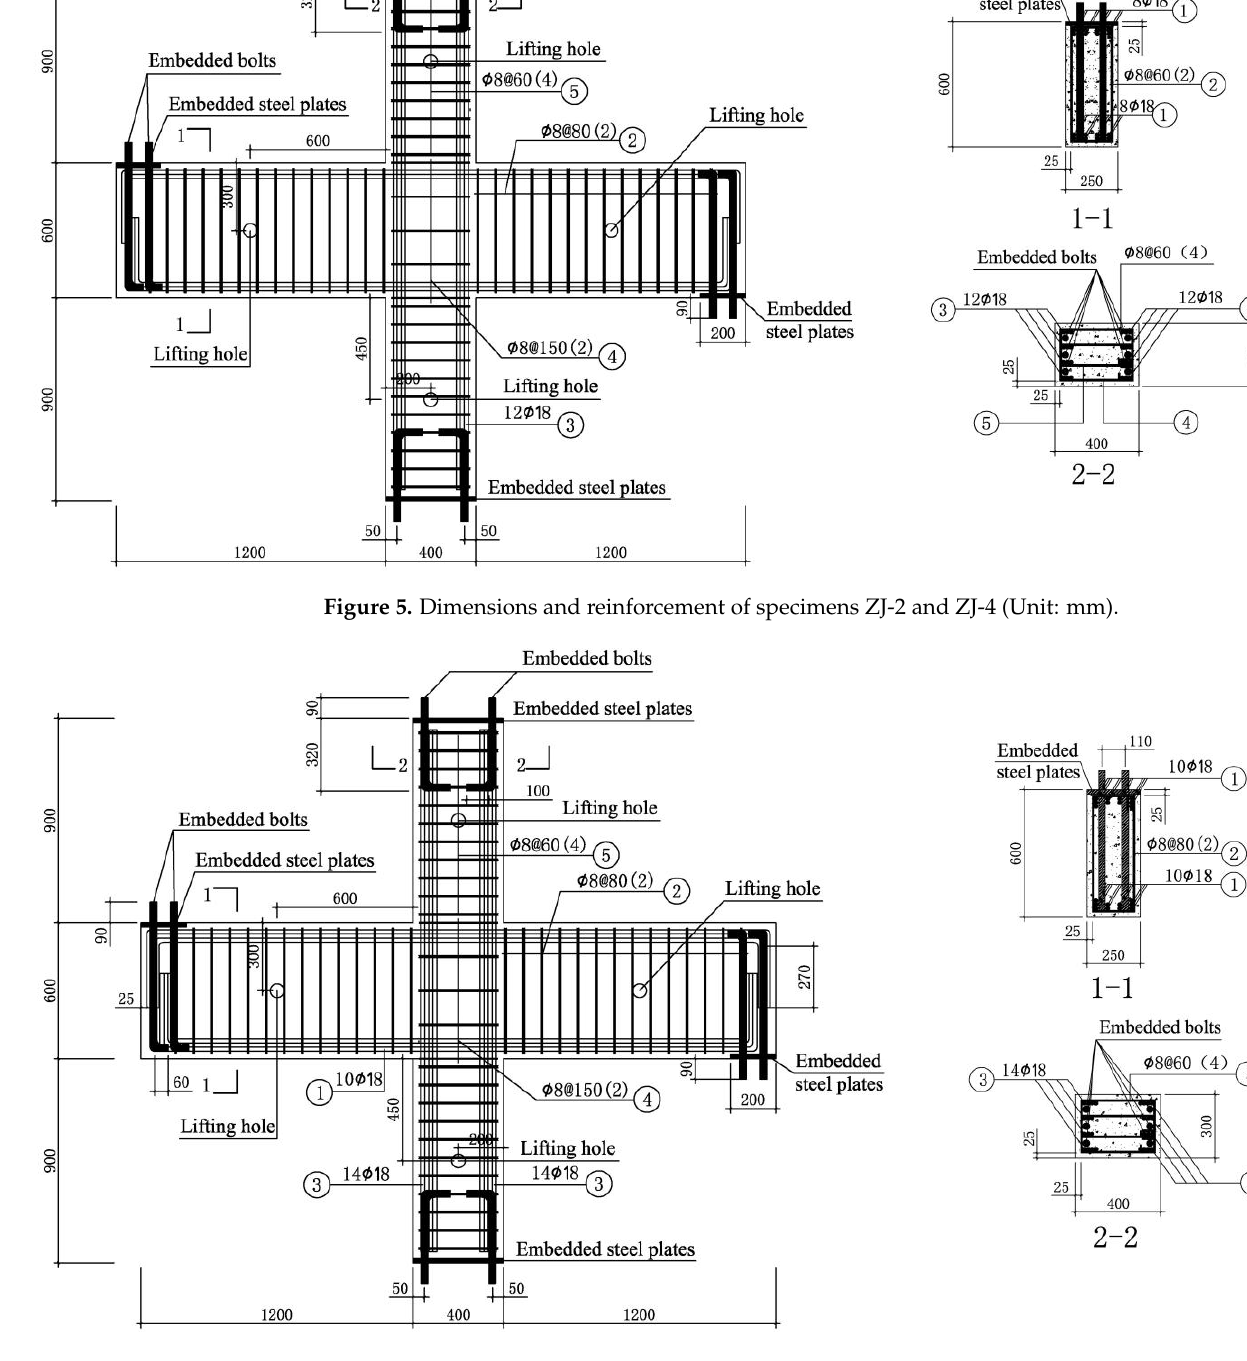
Figure 6. Dimensions and reinforcement of specimen ZJ-2A (Unit: mm).